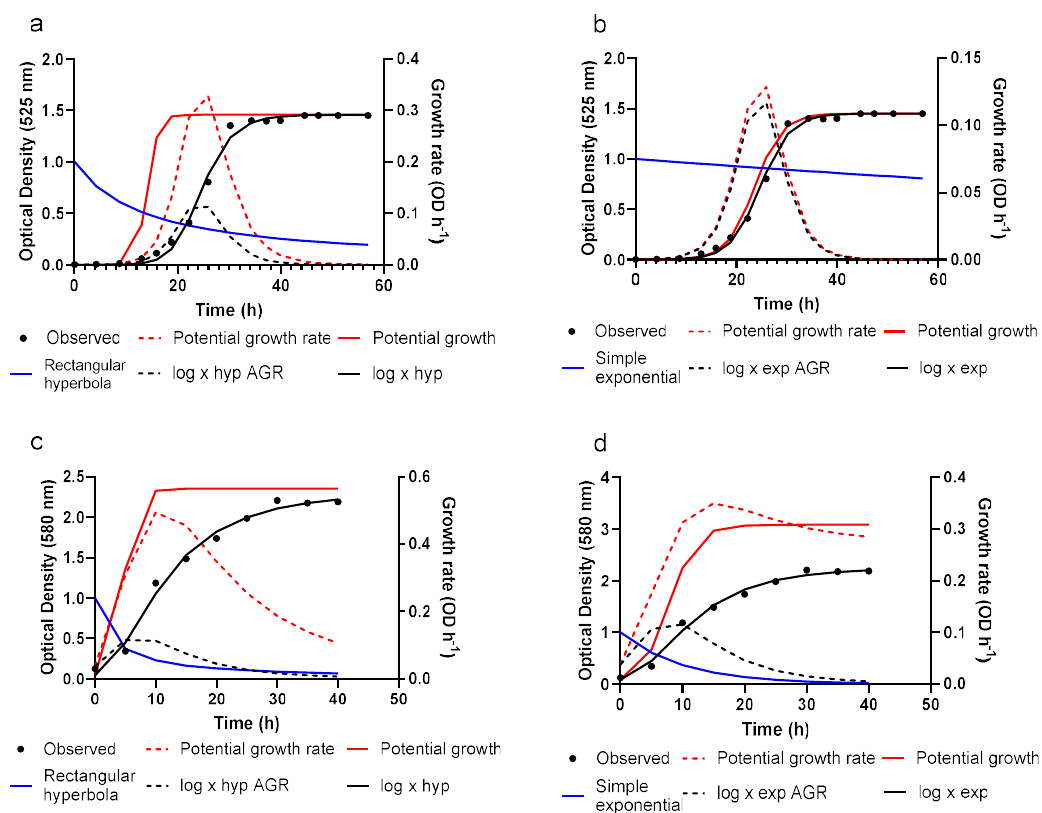
Figure 2. The e ff ect of dampening potential growth rate, resulting actual growth, and actual rate of growth (AGR) of Flavobacterium psychrophilum. Dampening e ff ect is represented by: a rectangular hyperbola ( a ), a simple exponential ( b ) when grown on a TYES liquid medium and a rectangular hyperbola ( c ), a simple exponential ( d ) when grown on FLBP liquid medium.